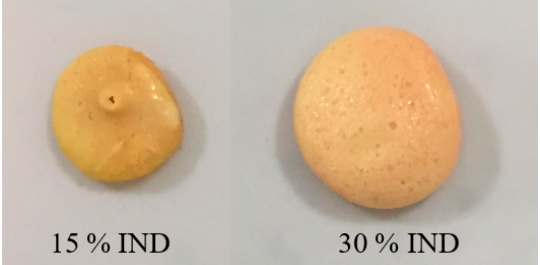
Figure 10. The physical appearance of post-dissolution injection moulded tablets of PVPVA-PEO-IND solid dispersions in pH 1.2 dissolution medium.